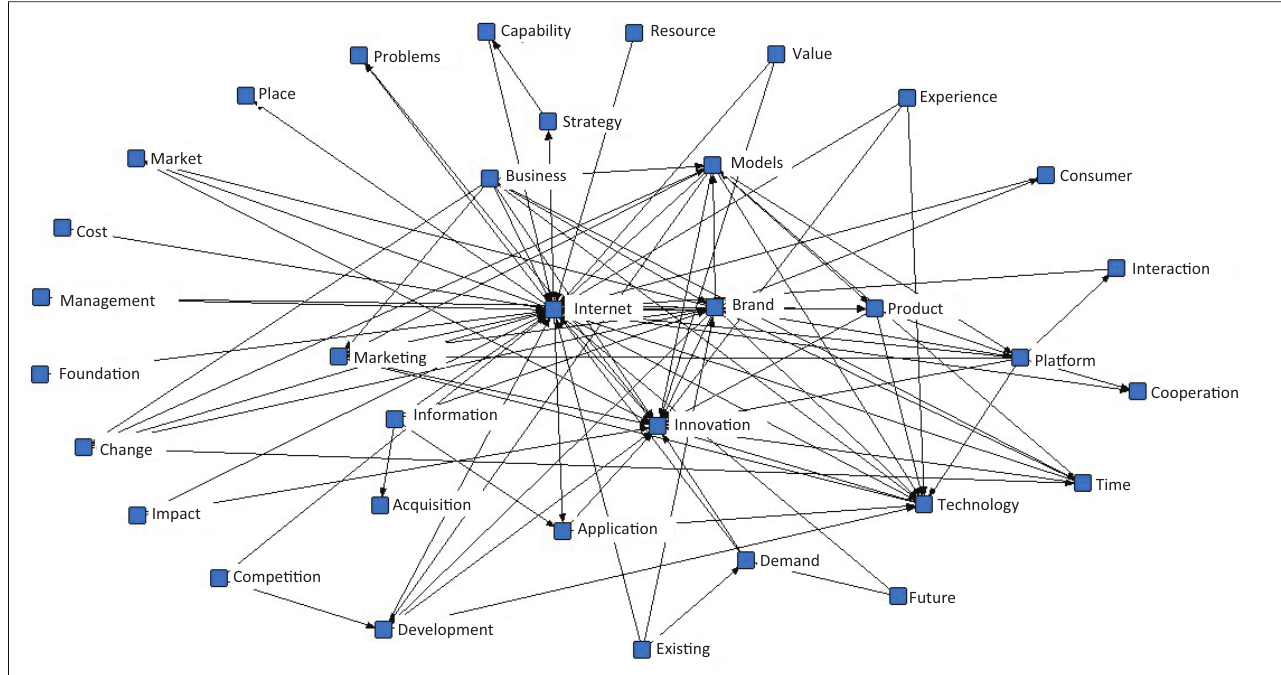
FIGURE 1: Collinear matrix of keywords.